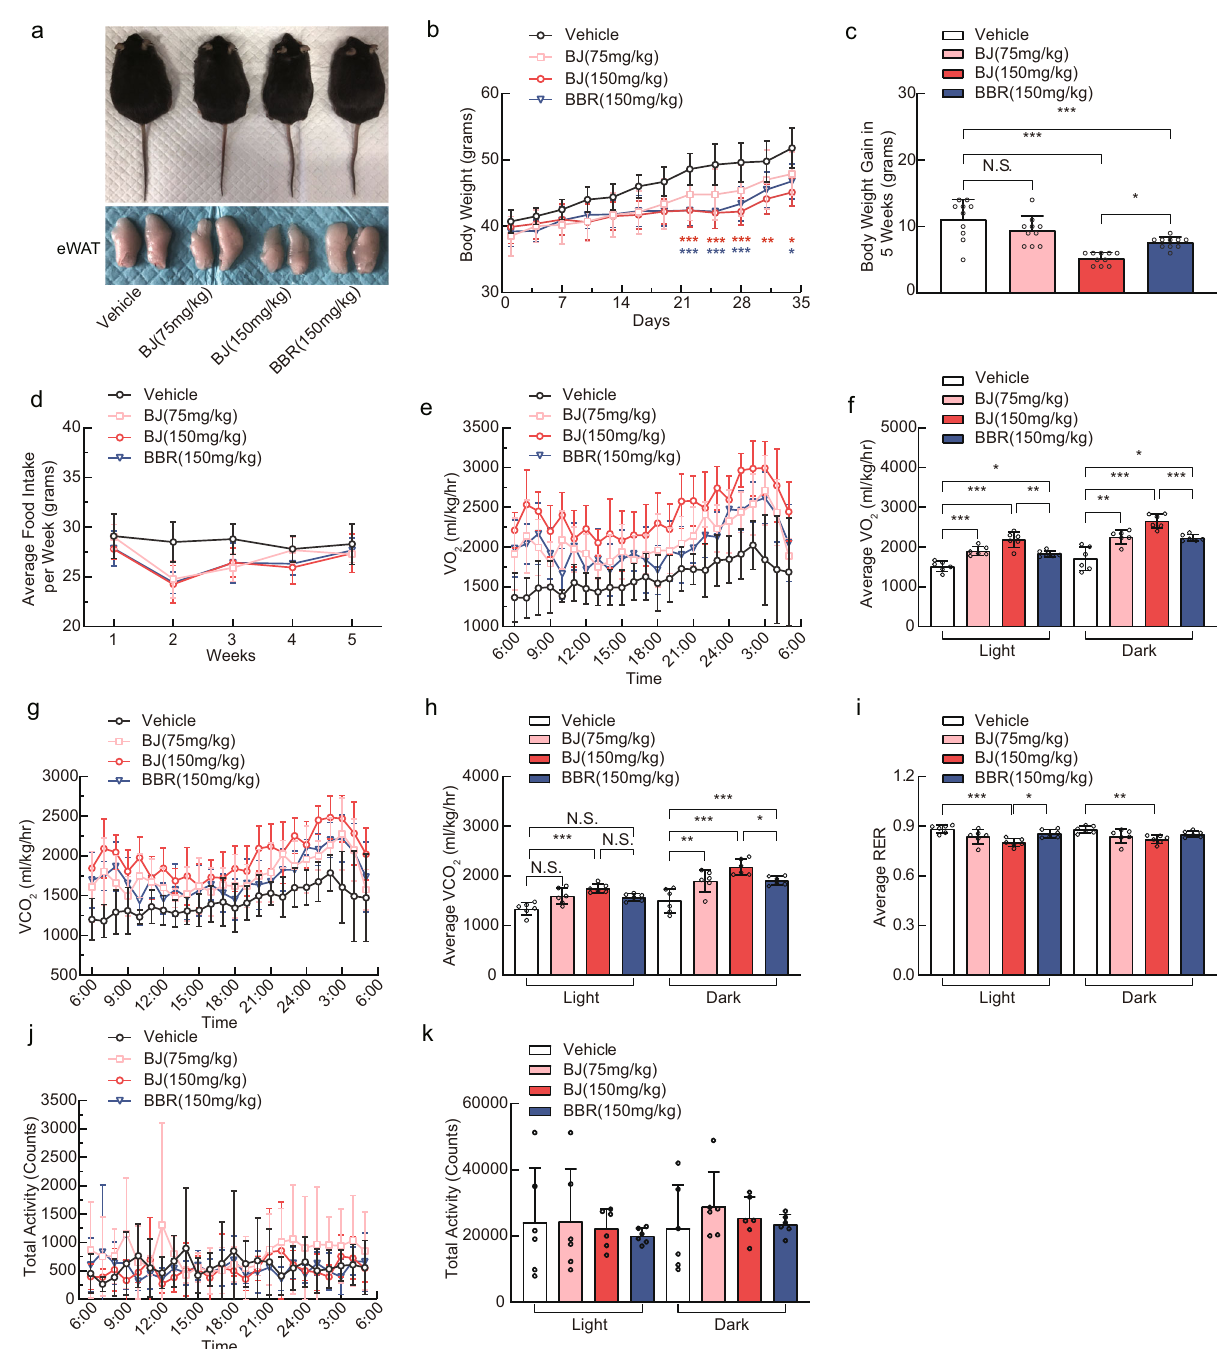
Fig. 3 BJ reduces body weight and promotes energy expenditure in db/db mice. a Representative images of db/db mice and their epididymal white adipose tissue (eWAT) form db/db mice treated with BJ or BBR. b , c Body weight of db/db mice in treatment groups ( n = 10 per group). d Changes of average food intake in each group during 5 weeks of treatment ( n = 6 per group). e – h Oxygen consumption (VO 2 ) ( e , f ) and carbon dioxide release (VCO 2 ) (g-h) of db/db mice within 24 h after treatment with BJ or BBR for 5 weeks ( n = 6 per group). i Respiratory exchange ratio (VCO 2 /VO 2 ) over a 24- h period in each group ( n = 6 per group). j , k Spontaneous horizontal activity of db/db mice over a 24-h period ( n = 6 per group). Data are expressed as mean ± SD. NS not signi fi cant, * P < 0.05, ** P < 0.01, *** P < 0.001.